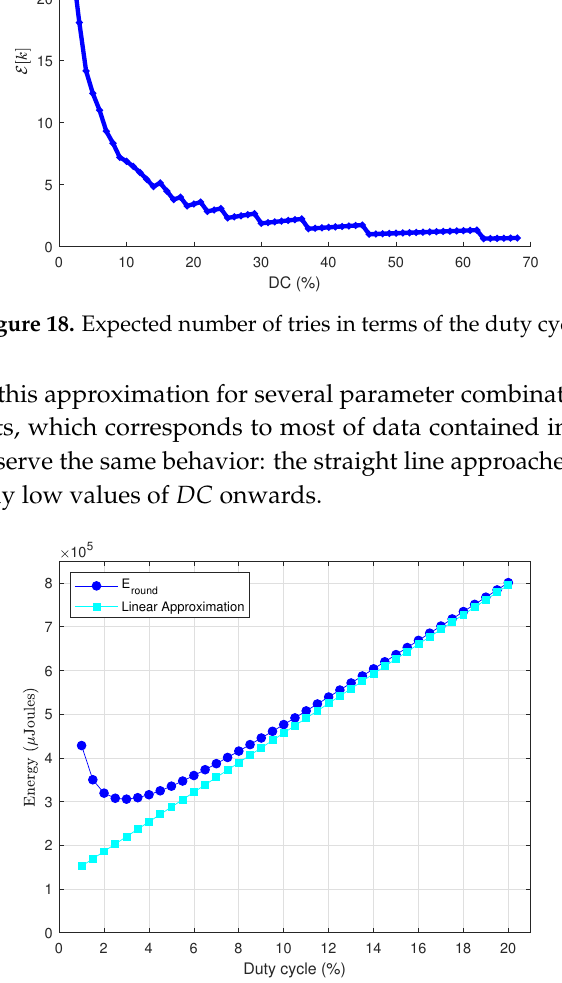
Figure 19. Linear approximation to E round ( X ) from moderately low values of DC , for σ ( X ) =